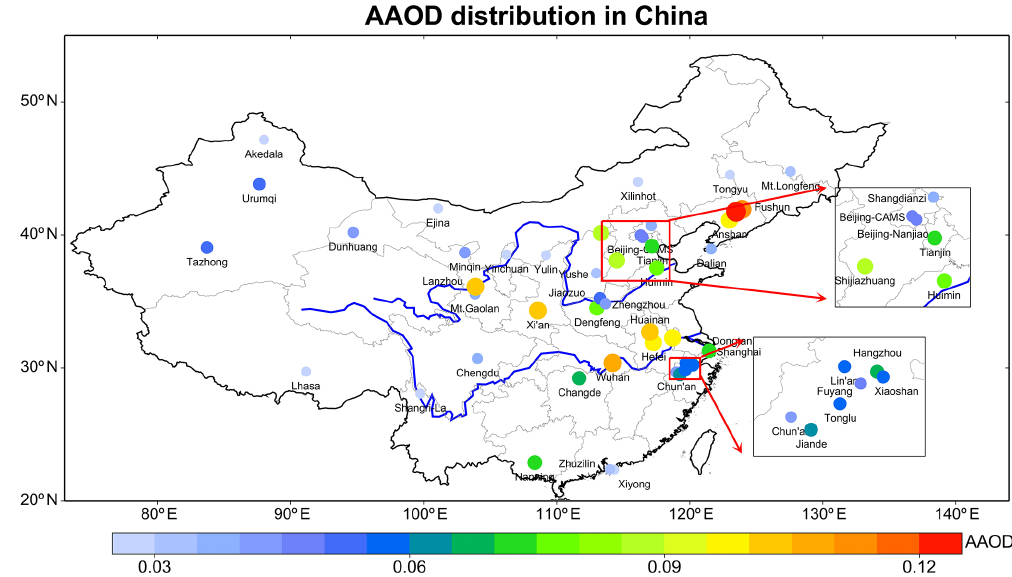
Figure 6. Annual spatial distribution of absorption aerosol optical depth (AAOD) at 440nm at the CARSNET sites.